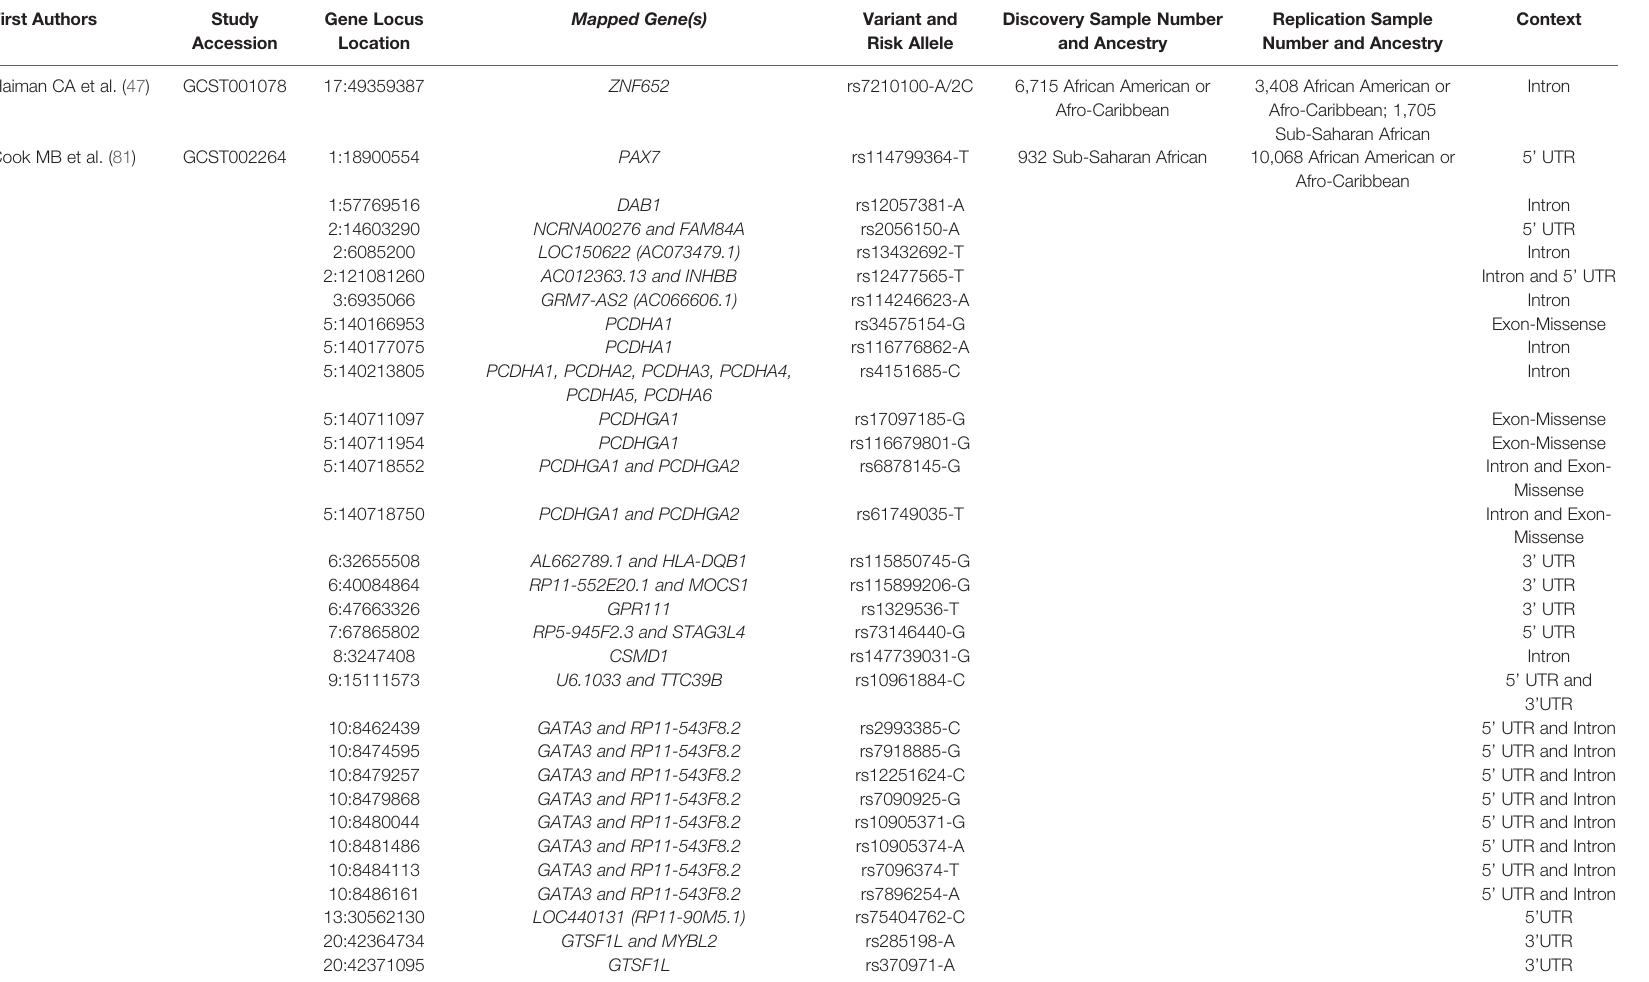
TABLE 1 | PCa associated genes reported from GWAS in African and men of African descent throughout the African